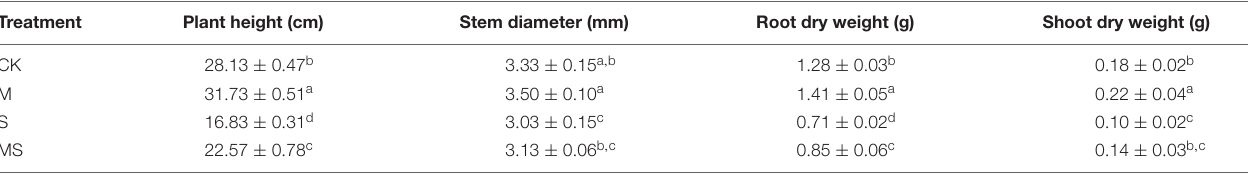
TABLE 2 | Growth parameters of watermelon inoculated (M, MS) or non-inoculated (CK, S) seedlings with AMF Funneliformis mosseae and subjected (S, MS) or not (CK, M) to salinity-alkalinity stress. Treatment Plant height